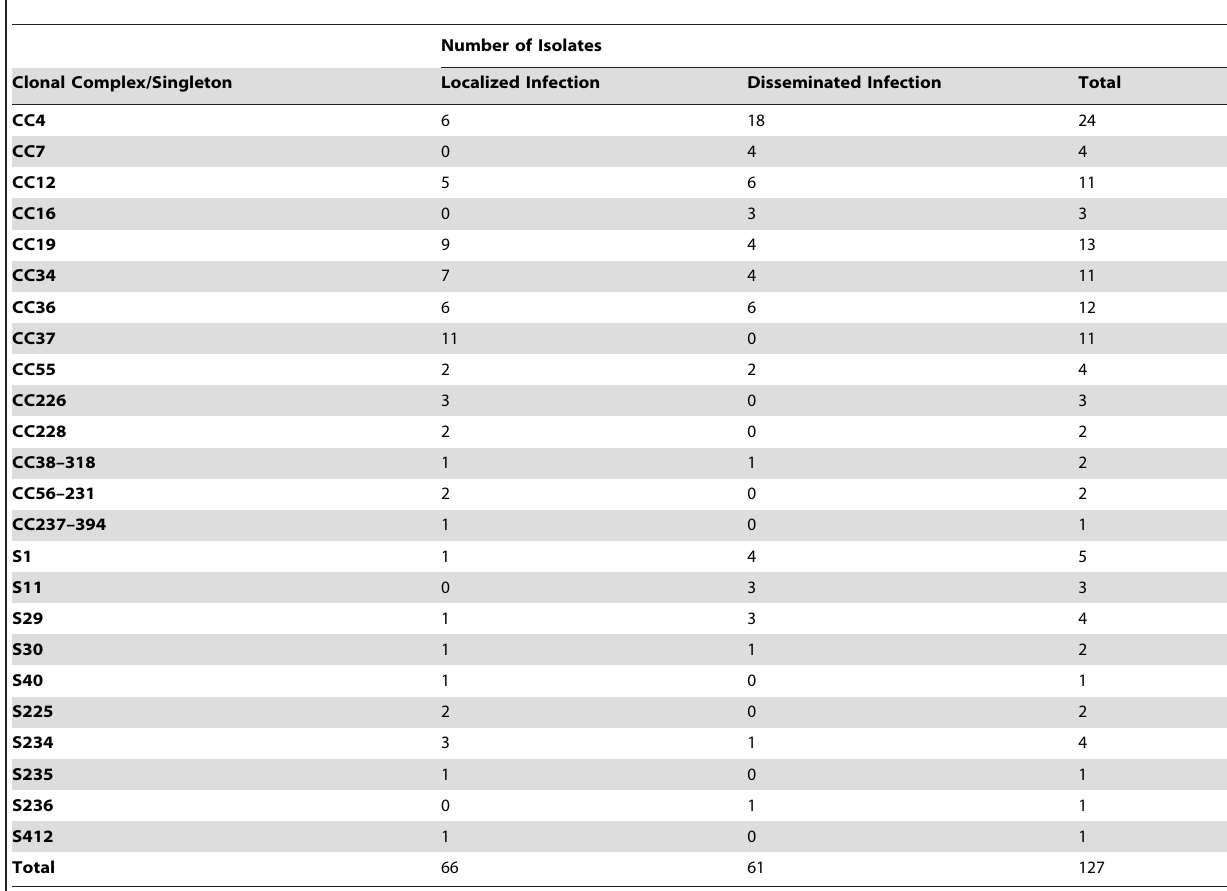
detect ecologically distinct groups within B. garinii (i.e., a bird- associated ecotype and a rodent-associated ecotype) [44] indicat- ing that this typing method has the power to detect and demarcate phenotypic differences of ecological significance among Lyme disease spirochetes. The present study represents the first application of this MLST scheme for analysis of the B. burgdorferi population structure in patients with Lyme disease, and the results indicate that phylogeny and pathogenicity of B. burgdorferi are correlated. Table 2. Distribution of B. burgdorferi isolates from Lyme disease patients with localized and disseminated infection between clonal complexes and